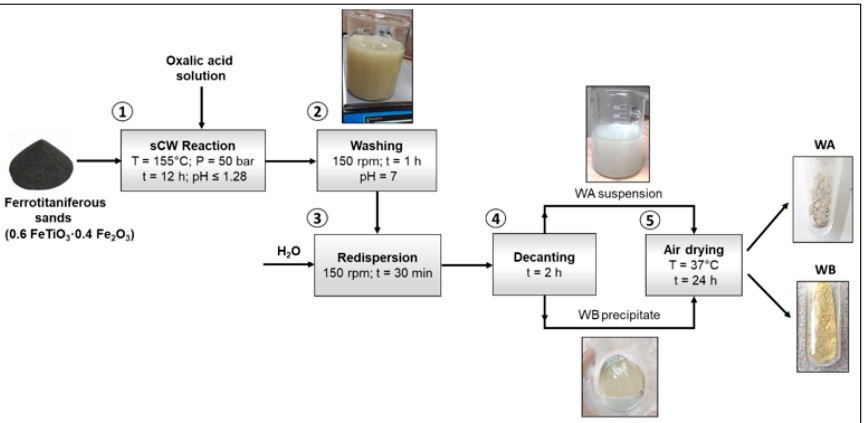
Figure 1. Scheme for the synthesis of iron and titanium-based compounds using a naturally occurring ferrotitaniferous black sand and oxalic acid aqueous solutions at sCW conditions (155 °C and 50 bar).